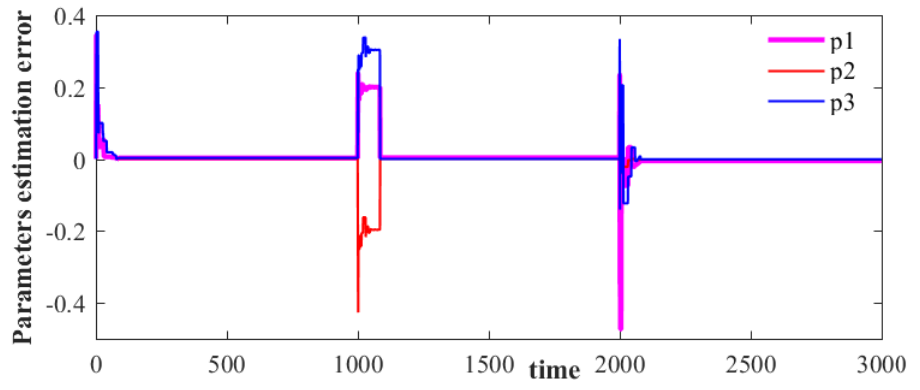
Figure 9. Correlation oefficient based parameters estimation error (noise free).